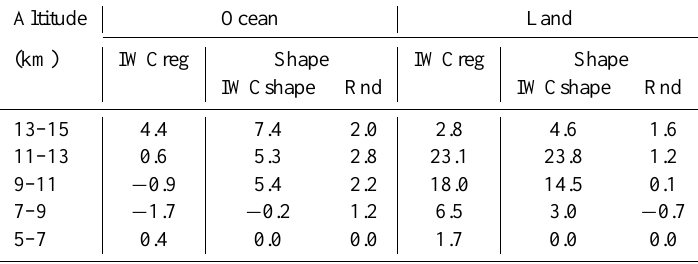
Table 3. Average IWCreg and IWCshape derivatives over ocean and land (expressed in % change in IWC/0.1 AOD units). Altitude